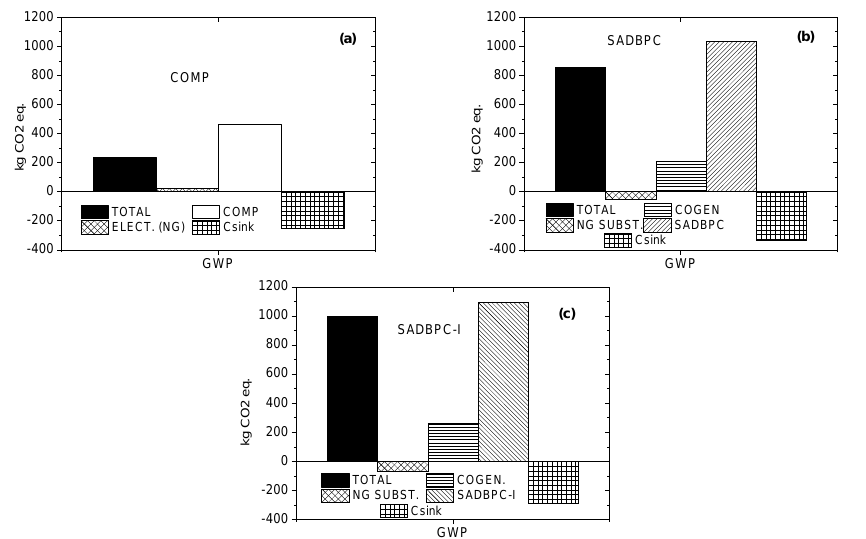
Figure 6. Contribution of main activities in GWP emission for the different scenarios: ( a ) composting (COMP), ( b ) solid anaerobic digestion batch and post-composting (SADBPC), and ( c ) solid anaerobic digestion batch inoculated and post-composting (SADBPC-I).